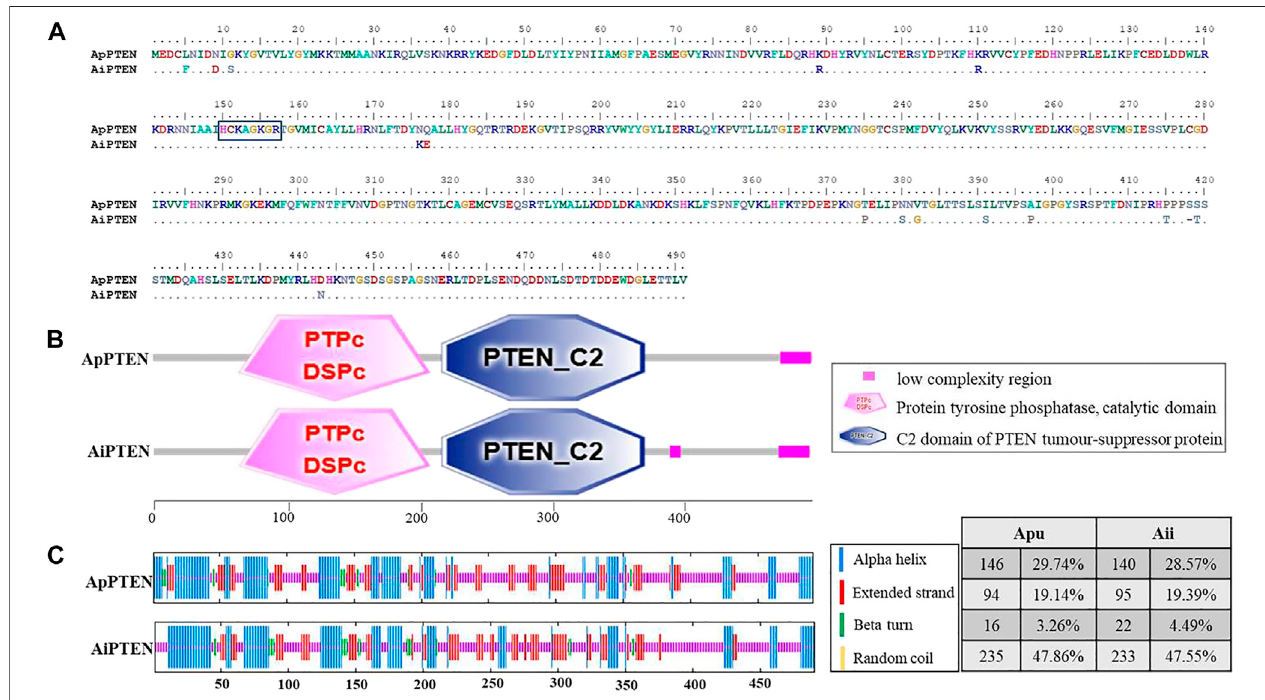
FIGURE 2 | The alignment (A) , functional domains (B) , and secondary structure (C) of the ApPTEN and AiPTEN.